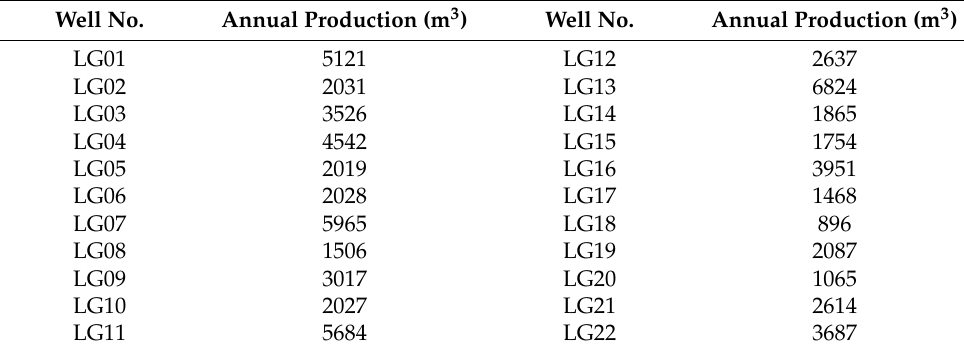
Table 2. Predicted annual oil production for the 22 producers with decline rate of 15%. Well